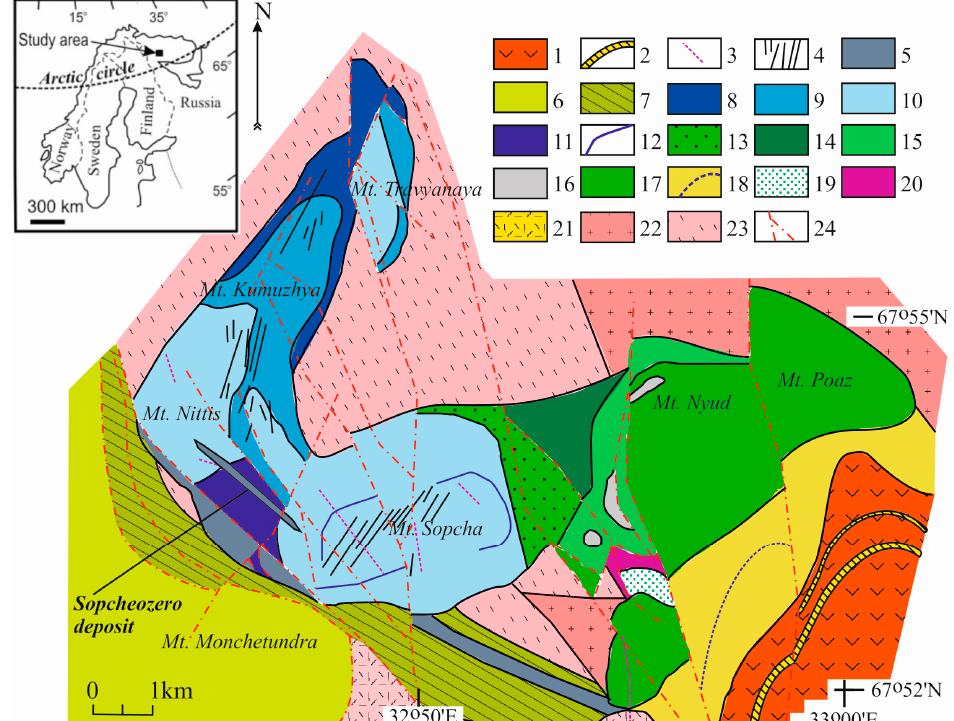
Figure 2. Geological map of the Monchepluton [1]. (1) Metavolcanics and (2) quartzite and schist of the Kuksha and Seidorechka formations of the Imandra–Varzuga Zone; (3) metadolerite and lamprophyre dykes; (4) sulfide veins of the NKT and Sopcha ore fields; (5) gabbro; melanonorite; and orthopyroxenite dykes; (6) gabbronorite and anorthosite of the Monchetundra massif; (7) blastocataclasite after gabbroic rocks; (8) harzburgite and rocks of the NKT bottom zone; (9) alternation of harzburgites; olivine and olivine-free orthopyroxenes; (10) orthopyroxenite; (11) dunite, plagioclase-bearing dunite and chromitite of the Dunite Block; (12) ore layer 330 on Mt. Sopcha; (13) plagioclase-bearing orthopyroxenite; (14) melanonorite; (15) olivine norite and harzburgite; (16) rocks of Critical Unit at Mt. Nyud; (17) norite; (18) metagabbronorite, gabbro, and anorthosite at foothills of Mt. Vurechuaivench; (19) amphibolized gabbro and (20) diorite of the 10th Anomaly; (21) silicic volcanics at Mt. Arvarench; (22) diorite and granodiorite, and (23) garnet-biotite, amphibole, and high-alumina gneisses and migmatites of the Archean complexes, and (24) faults. The Monchepluton has an arched shape in plan close to its initial shape and The northeastern chamber (NKT and Sopcha massifs) is composed (from bottom to top) of quartz-bearing norites and gabbronorites of the basal zone with a thickness of